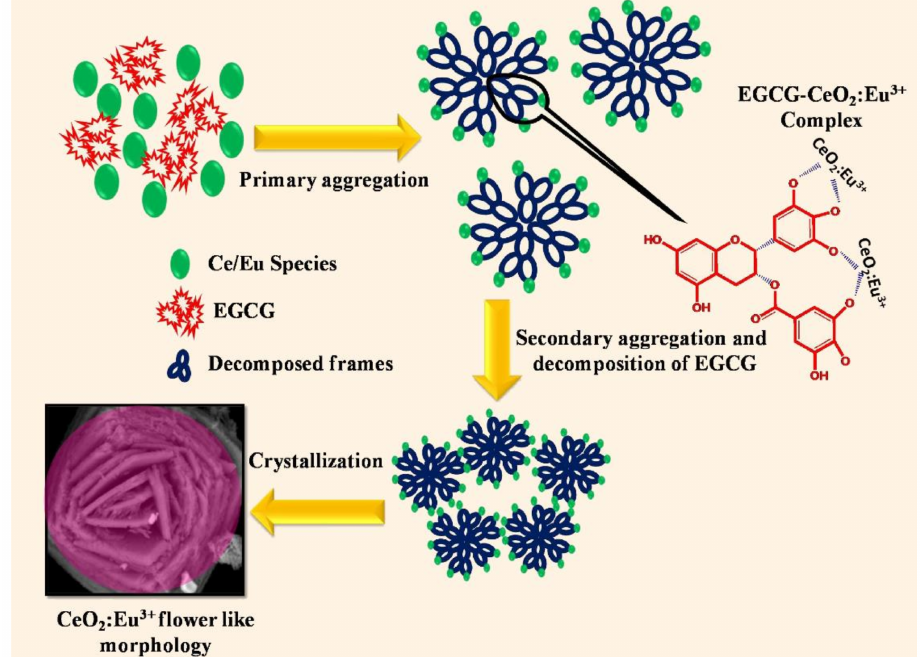
Figure 4. Epigallocatechin gallate (EGCG) biomolecular template for the nucleation and growth of ceria nanocrystallits that further assemble into a flower morphology. Reprinted from [38], Copyright © 2021, with permission from